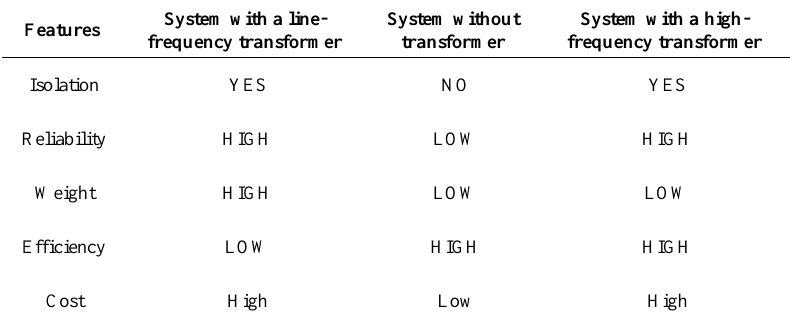
Table 1 . different characteristics of the mentioned topologies